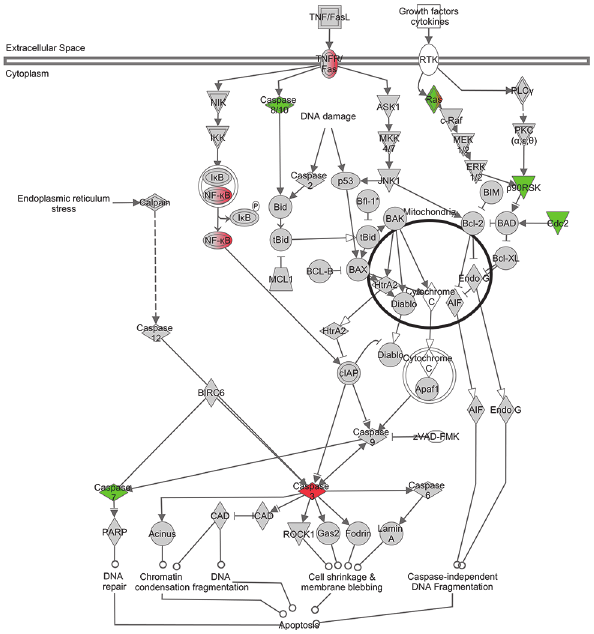
Fig 4. Differential mRNA expression in quadriceps muscle from Cfl2 deficient mice compared to wild- type littermates for apoptosis. Color representations are the same as described in Fig 3.